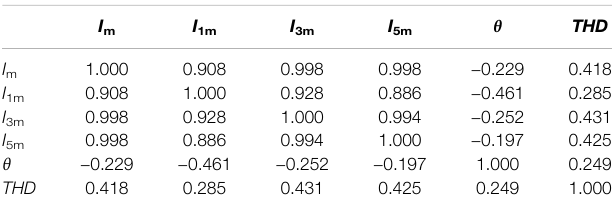
TABLE 2 | The coef fi cient of LC eigenvalues on clean insulator. TABLE 3 | The coef fi cient of LC eigenvalues ( ESDD (cid:2) 0.1 mg/cm 2